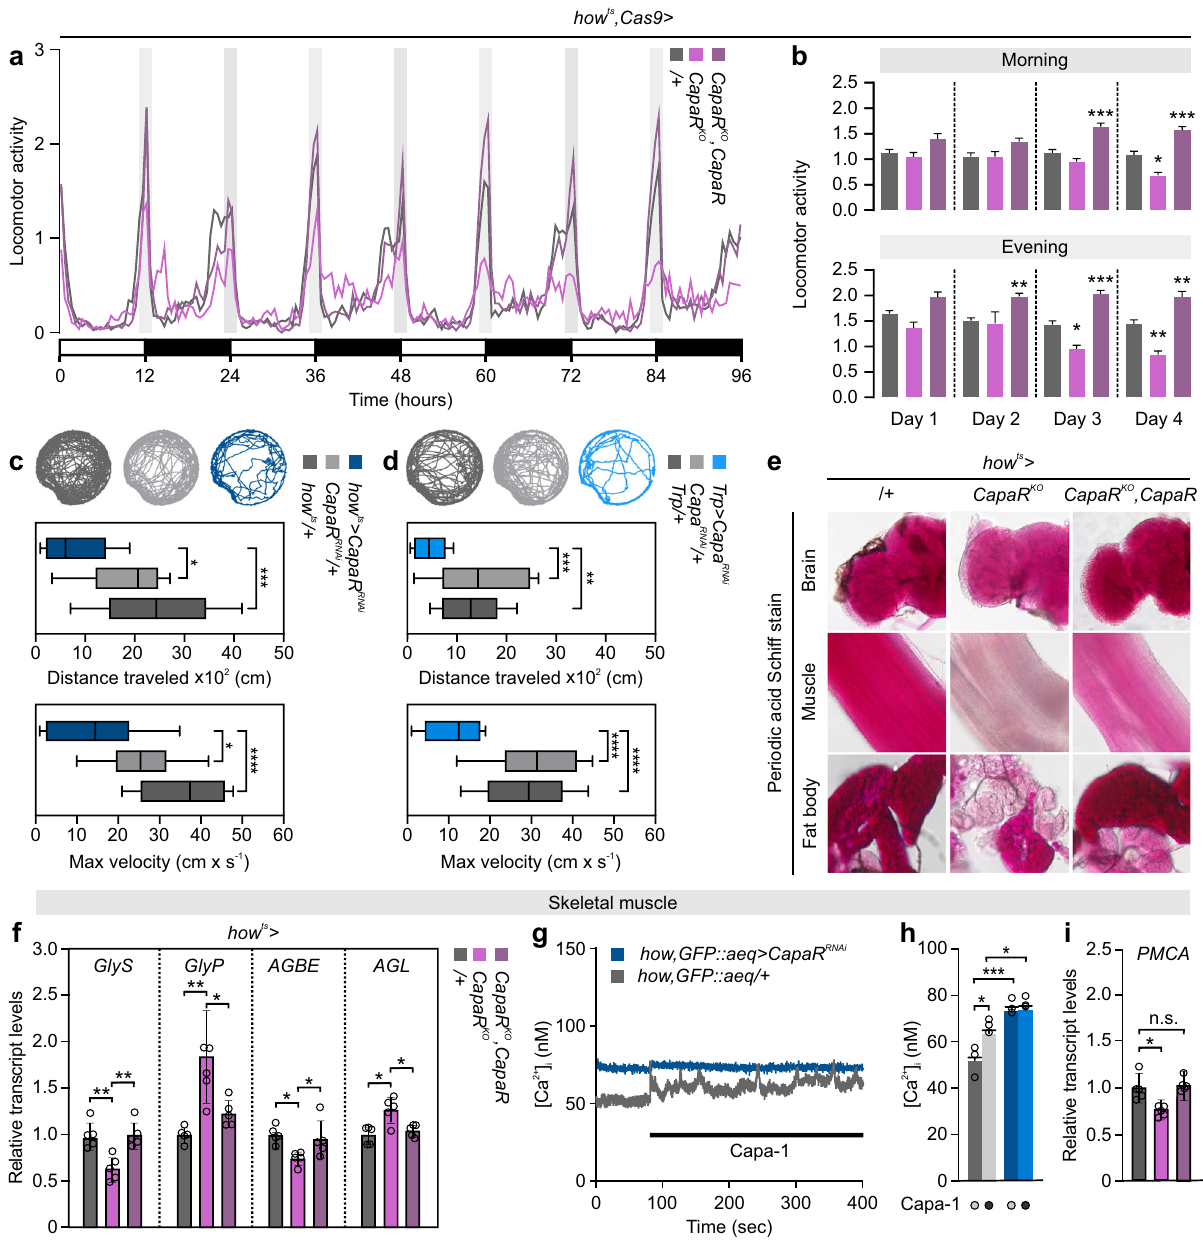
Fig. 6 Muscle-speci fi c CapaR elimination induces locomotor defects. a Locomotor activity of individual control ( / + ; n = 31), muscle-speci fi c CapaR knockout ( how ts > CapaR KO ; n = 20) and rescue ( how ts > CapaR KO , CapaR ; n = 31) fl ies exposed to 12-hour:12-hour, light-dark (LD) cycles for 96 h. The experiment was repeated twice with the same results. b Stereotypic morning and evening activity peaks measured over the experimental period (mean ± SEM; one-way ANOVA; * P < 0.05; ** P < 0.01; *** P < 0.001). c – d Representative activity traces of video-tracked individual fl ies with targeted CapaR silencing in muscles ( how ts > CapaR RNAi ; n = 16) or Capa knockdown in Capa + neurons ( Trp > Capa RNAi ; n = 16) relative to control fl ies ( n = 10), including quanti fi cations of distance traveled and max velocity (Tukey ’ s box-plots; whiskers: min and max; box: 25th and 75th percent quartiles; middle: median; one- way ANOVA; * P < 0.05; ** P < 0.01; *** P < 0.001; **** P < 0.0001). e Periodic Acid-Schiff ( P AS) staining in the brain, skeletal muscle (from thorax), and fat body showed depleted carbohydrate stores in these tissues of how ts > CapaR KO fl ies relative to control, with partial rescue in fl ies additionally carrying a CapaR transgene ( how ts > CapaR KO ,CapaR ). f Transcript levels of GlyS, GlyP , AGBE and AGL relative to RpL3 in skeletal muscles (thorax samples) from muscle-speci fi c CapaR knockout ( how ts > CapaR KO ) compared to control ( how ts / + ) and rescue ( how ts > CapaR KO ,CapaR ) fl ies (mean± SEM; one-way ANOVA; * P < 0.05; ** P < 0.01; n = 5). g Stereotypic cytosolic calcium traces in skeletal muscles (thorax samples) expressing the